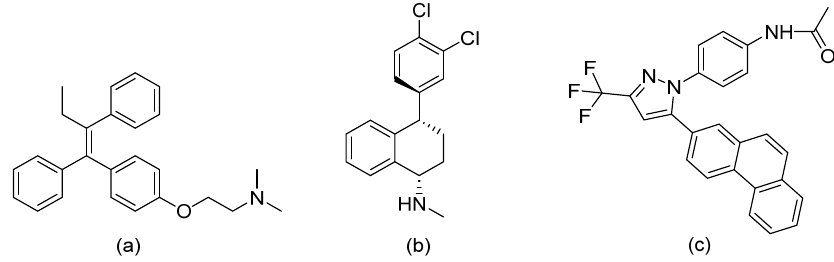
Figure 17. The chemical structures of ( a ) tamoxifen, ( b ) sertraline, and ( c )